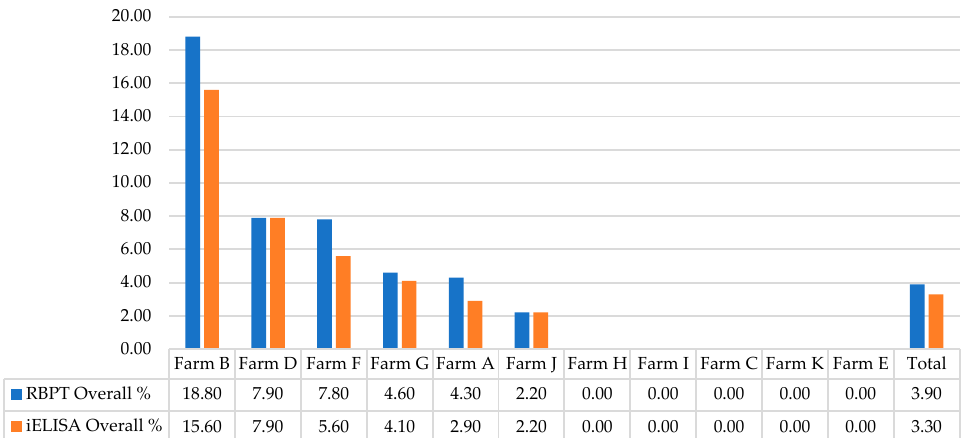
Figure 2. Farm-wise seroprevalence of brucellosis. RBPT—Rose Bengal Plate Agglutination Test; iELISA—Indirect Enzyme-Linked Immunosorbent Assay.